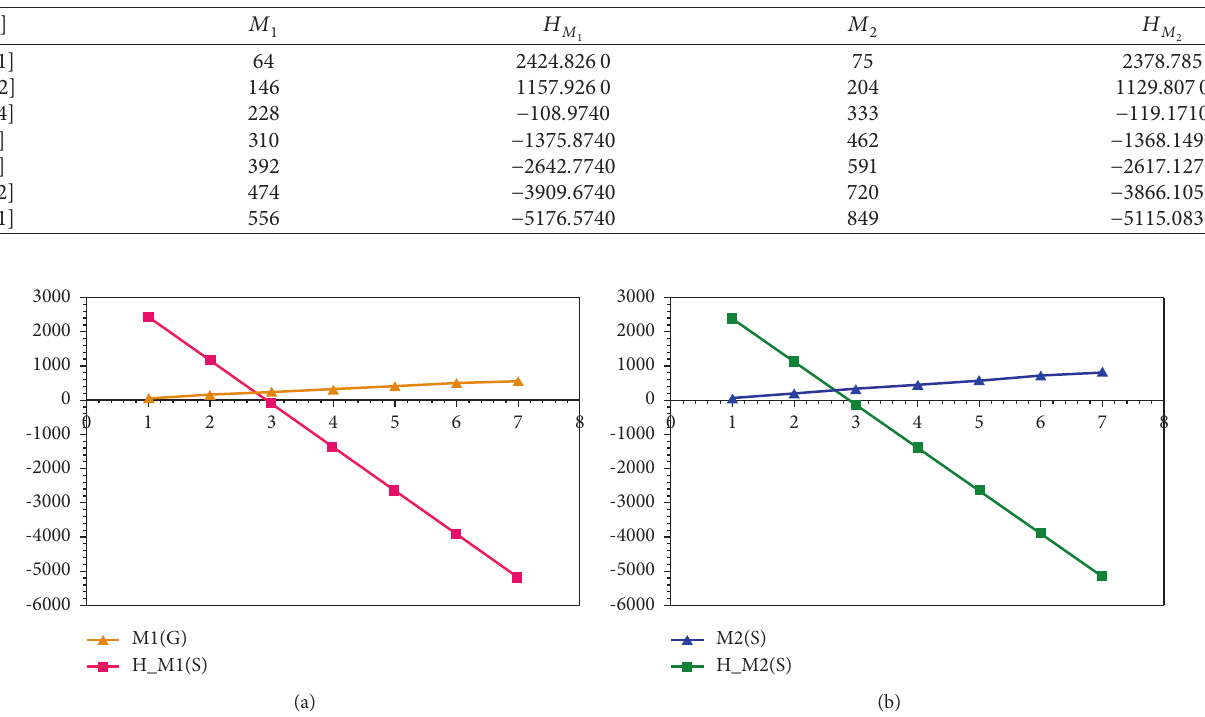
Table 6: Comparison of Zagreb indices with their respective heat of formations for GST − SL [ n ] .